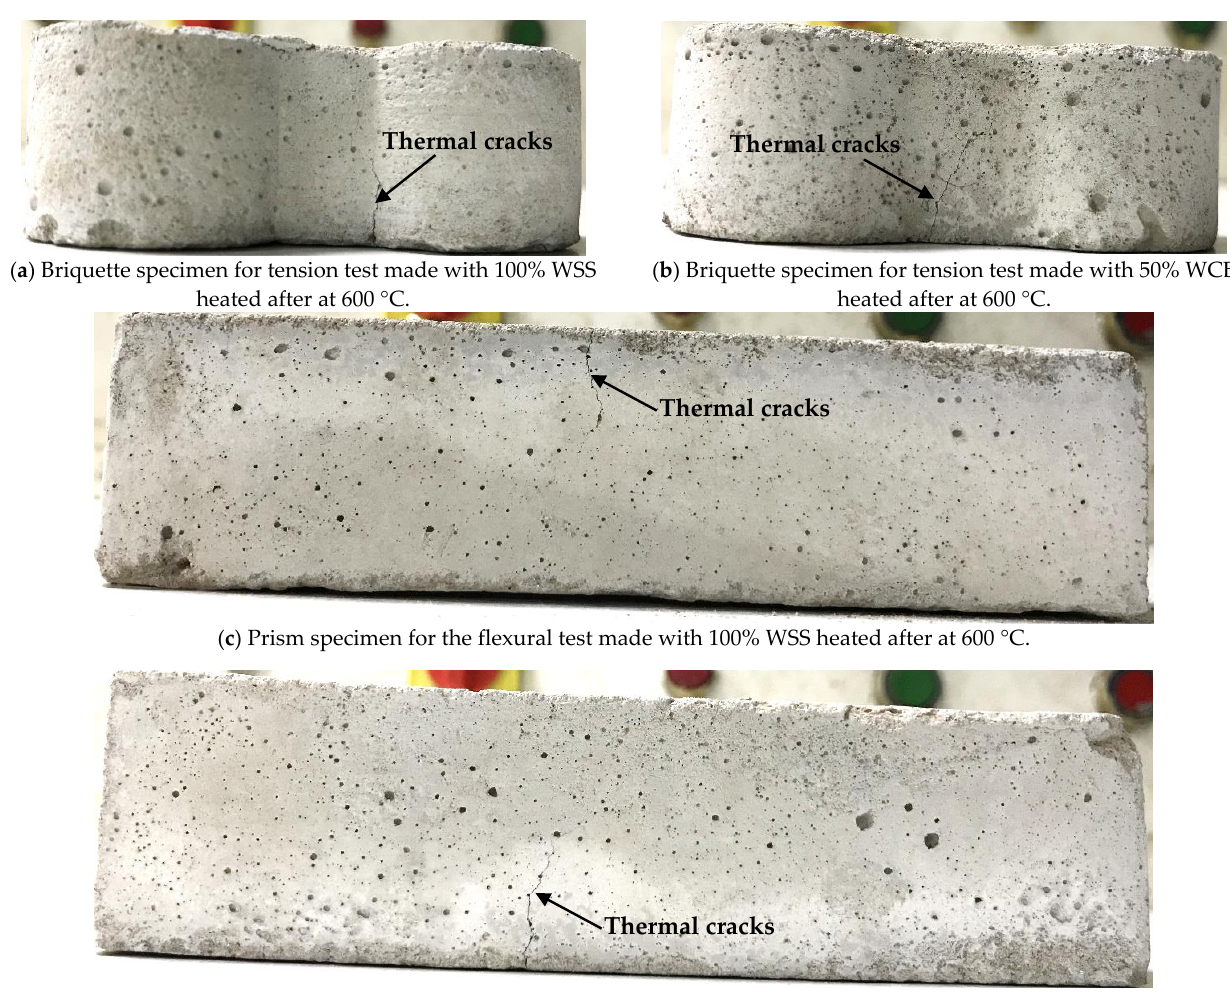
Figure 10. Images of mortar specimens after exposure to 600 °C: tensile test specimens ( a,b ) and flexural test specimens ( c,d ).